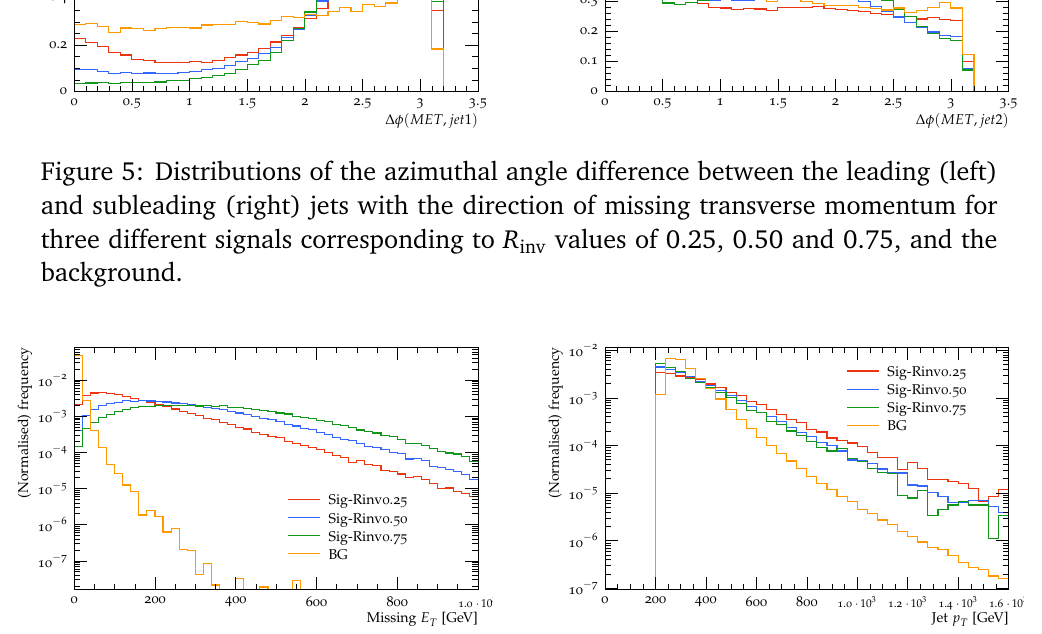
(left) for three different T